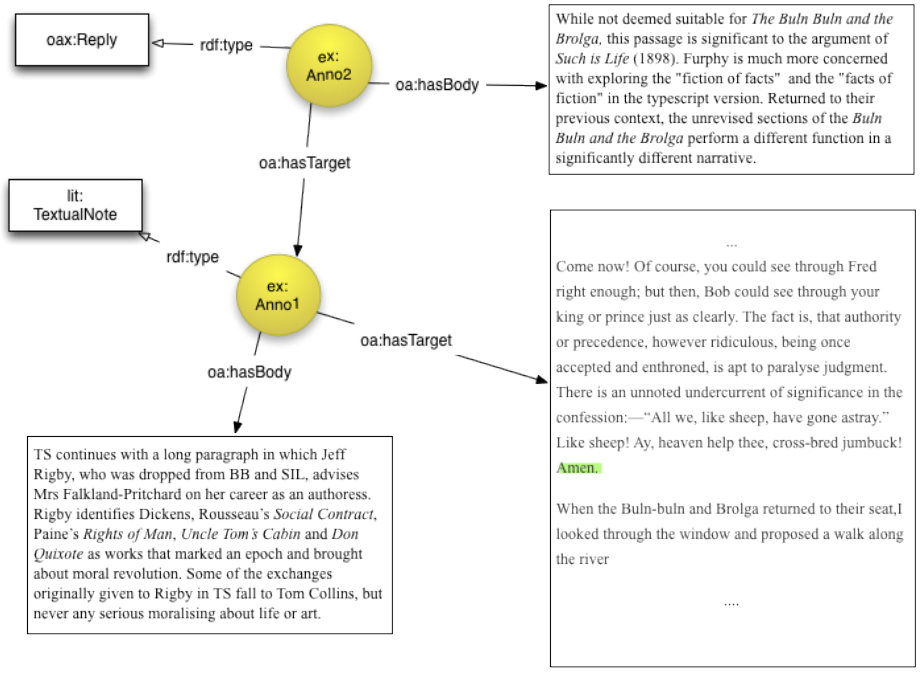
Figure 4. OA instance illustrating a reply to an existing